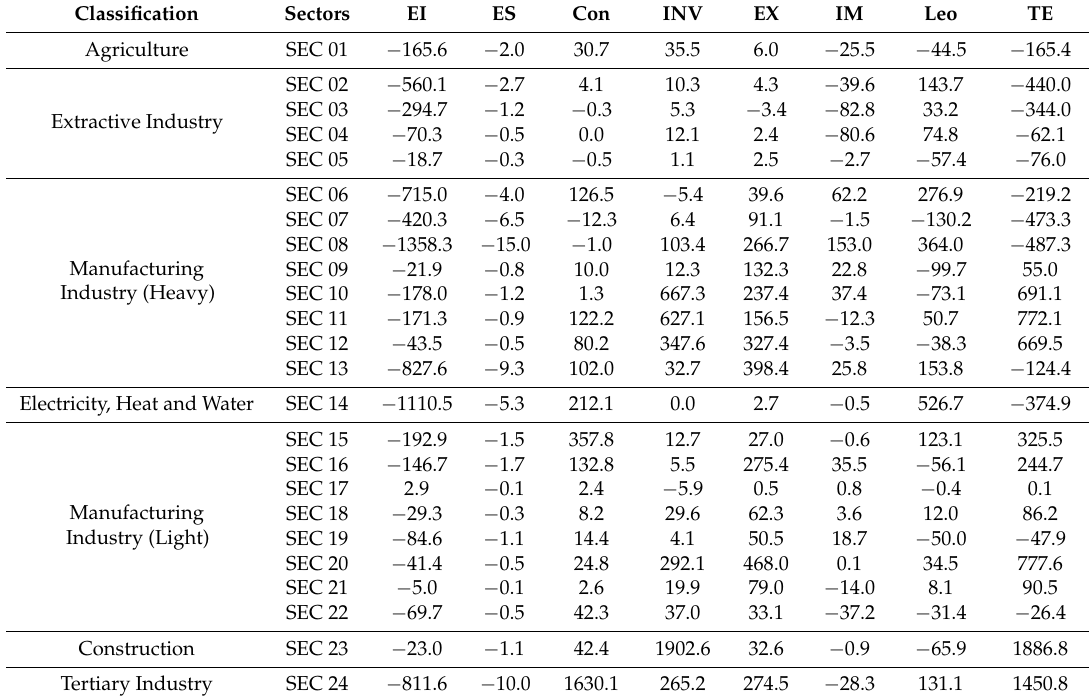
Table 6. Decomposition factors in sub-industries 1997–2010 (Million ton CO 2